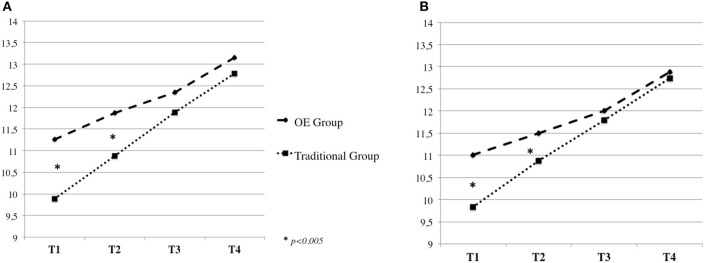
Kuno Beller play (A) and language (B).